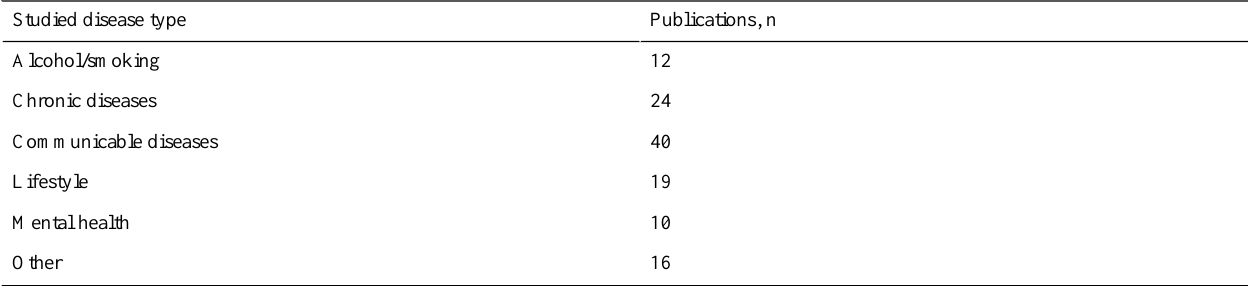
Table 6. Distribution of publications by studied disease type